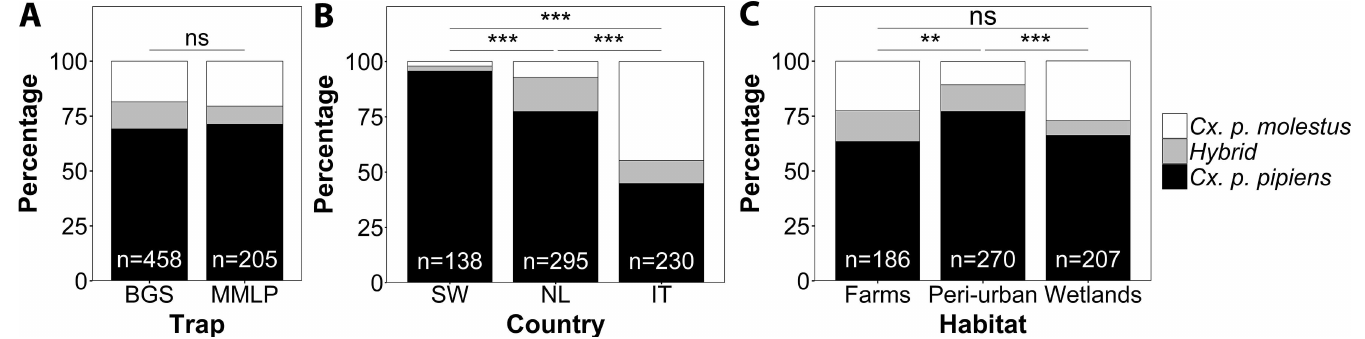
Fig 1. Main effects of (A) trap type, (B) country, and (C) habitat on the ratio of Culex pipiens biotypes and their hybrids. The total sample size (n) is indicatedfor each bar. Significance is displayedfor each pairwisecomparison, with ns = not significant, ** = p < 0.01, *** = p < 0.001. BGS = Biogents Sentineltrap, MMLP = MosquitoMagnet Liberty Plus, SW = Sweden,NL = The Netherlands, and IT =